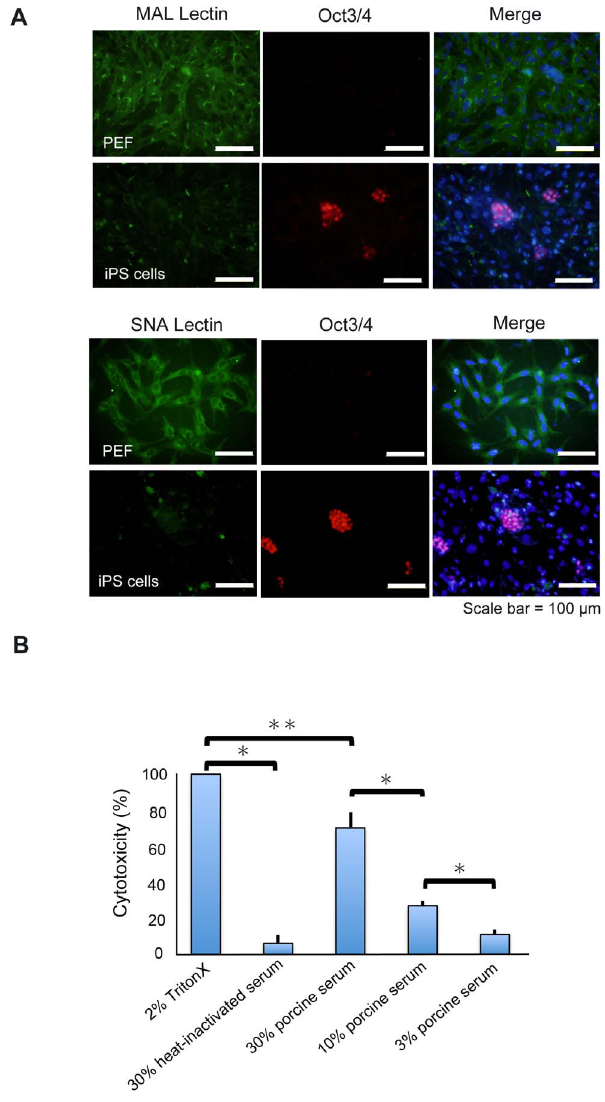
Figure 3. Complement-mediated cytotoxicity to C1 iPS cells. (A) Cytochemical assay for sialic acids using lectins. The expression of sialic acids was examined with SNA lectin and MAL lectin, both of which specifically bind to sialic acids. C1 iPS cells exhibited very low levels of sialic acids compared to fibroblasts. C1 iPS cells, but not PEFs, expressed Oct3/4. (B) Cell injury by complement was assessed by measuring LDH released in the supernatants described in the Materials and Methods. Triton-X (2%) was used as a positive control, and 30% of heat- inactivated (complement-inactivated) serum was used as a negative control. The percent cytotoxicity was indicated as average values of triplicate ( * p , 0.01, ** p , 0.05). Three independent experiments were conducted and similar results were